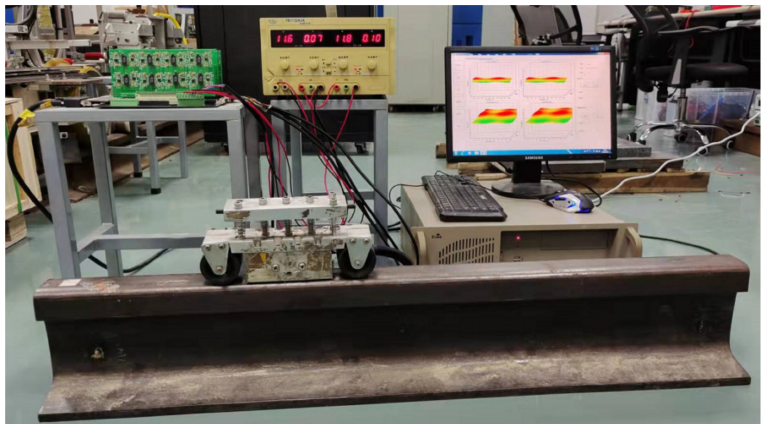
Figure 8. MFL detection